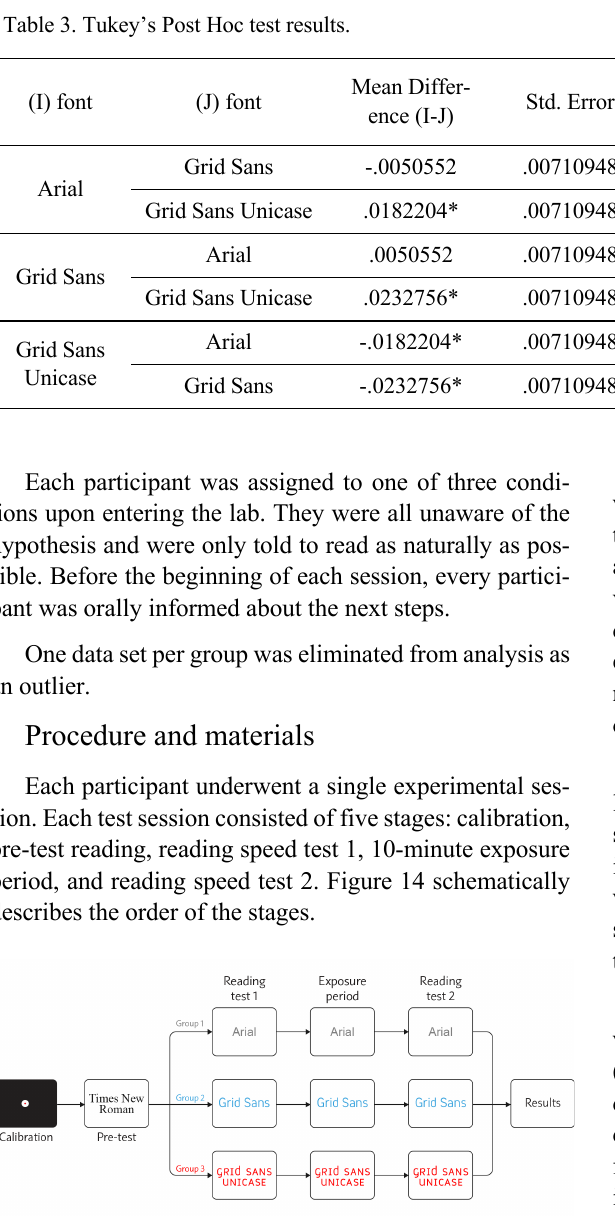
Figure 14. Experiment procedure.